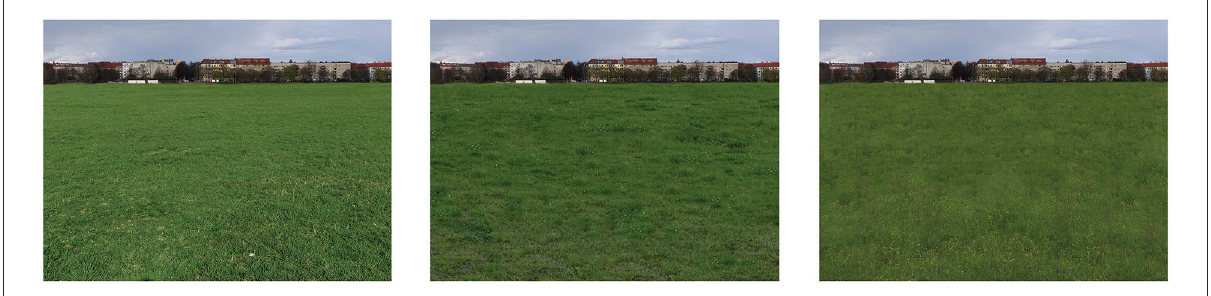
FIGURE1 Stimuli material for Berlin (from the left: low, medium, and high biodiversity). Instruction: In which of these places would you feel most comfortable? Please take your time and have a look at all three pictures and then point to the chosen